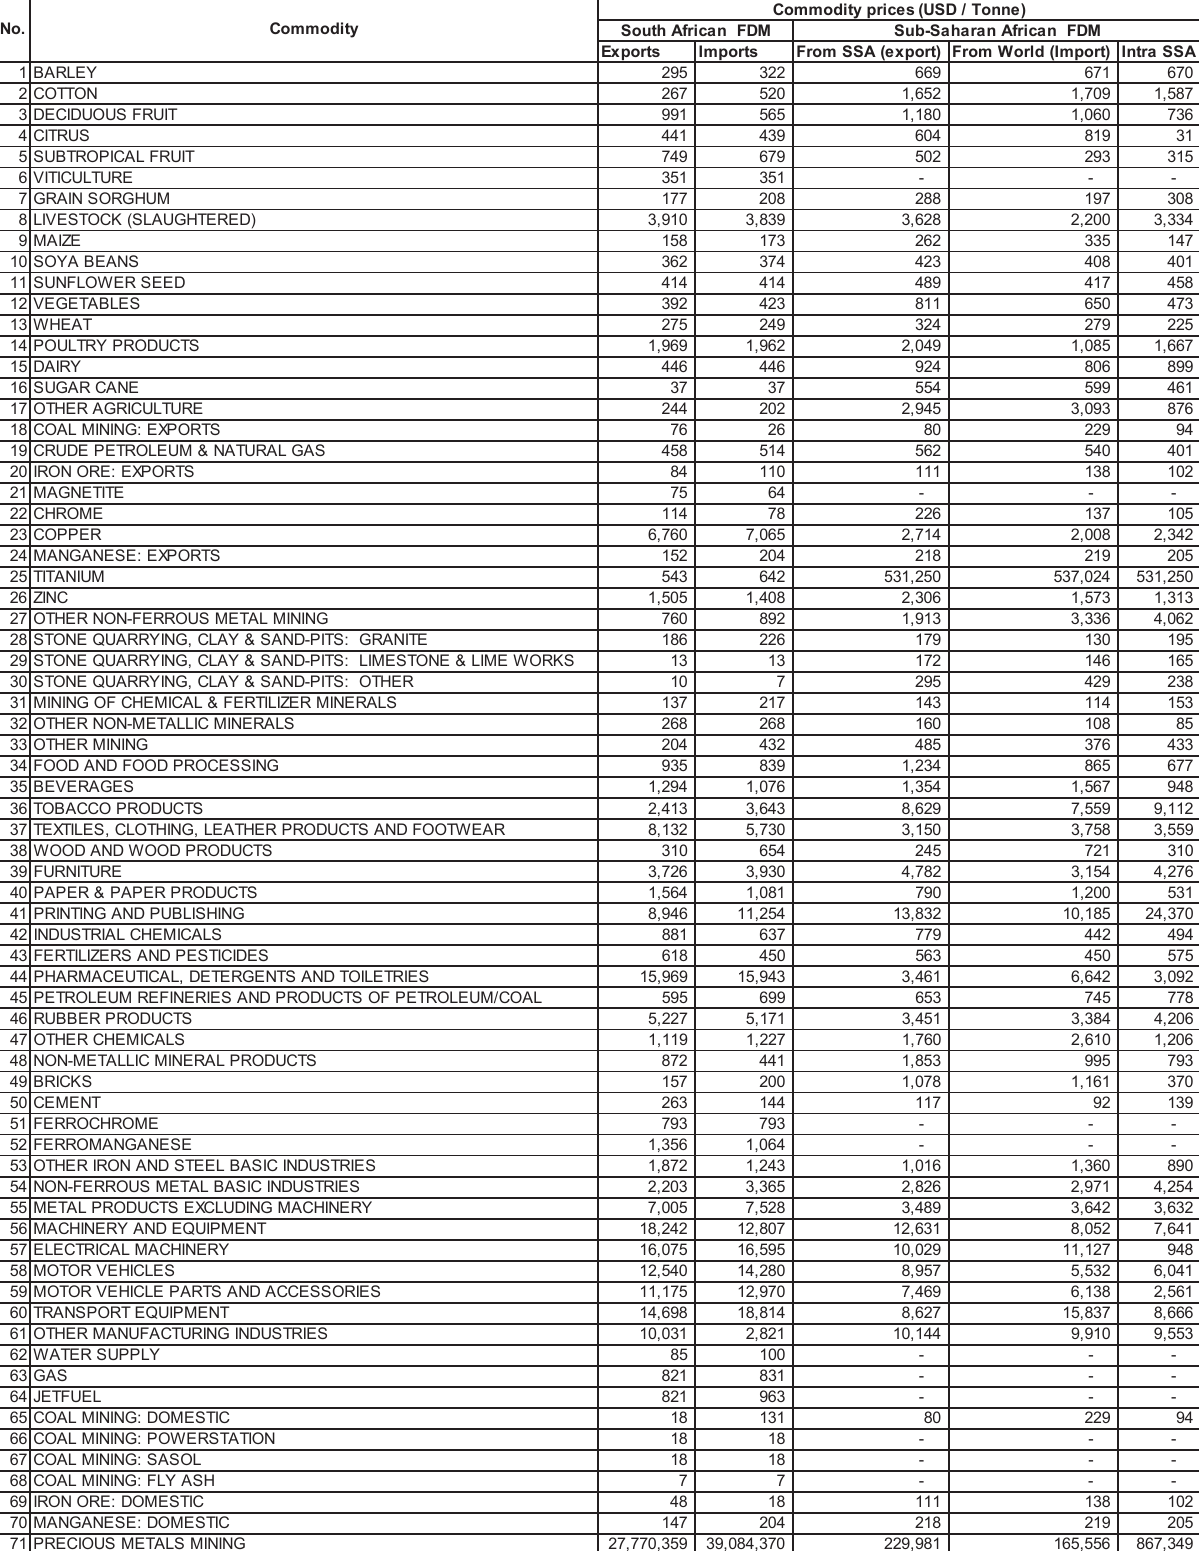
Table 1: Comparison of SSA FDM commodity rates with South African FDM commodity rates